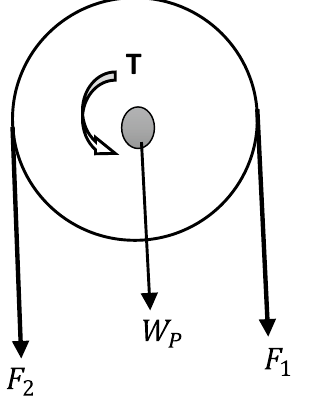
Figure 9. Free body diagram (FBD) of top section of belt elevator